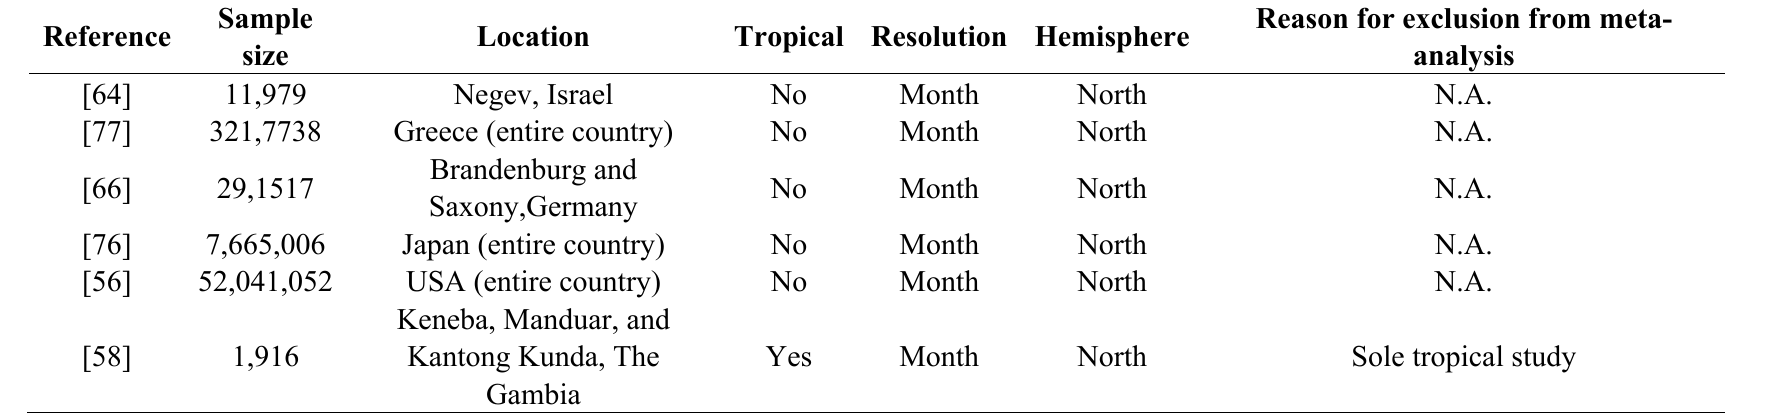
Table A16. Studies examined for the meta analysis of the influence of month of birth on preterm birth and gestational length.